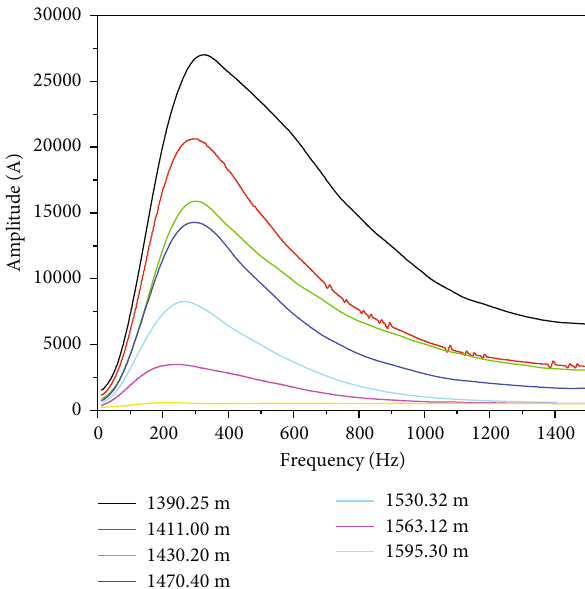
Figure 12: Well 13-1-2 ultrasonic multiphase fl ow test power spectrum